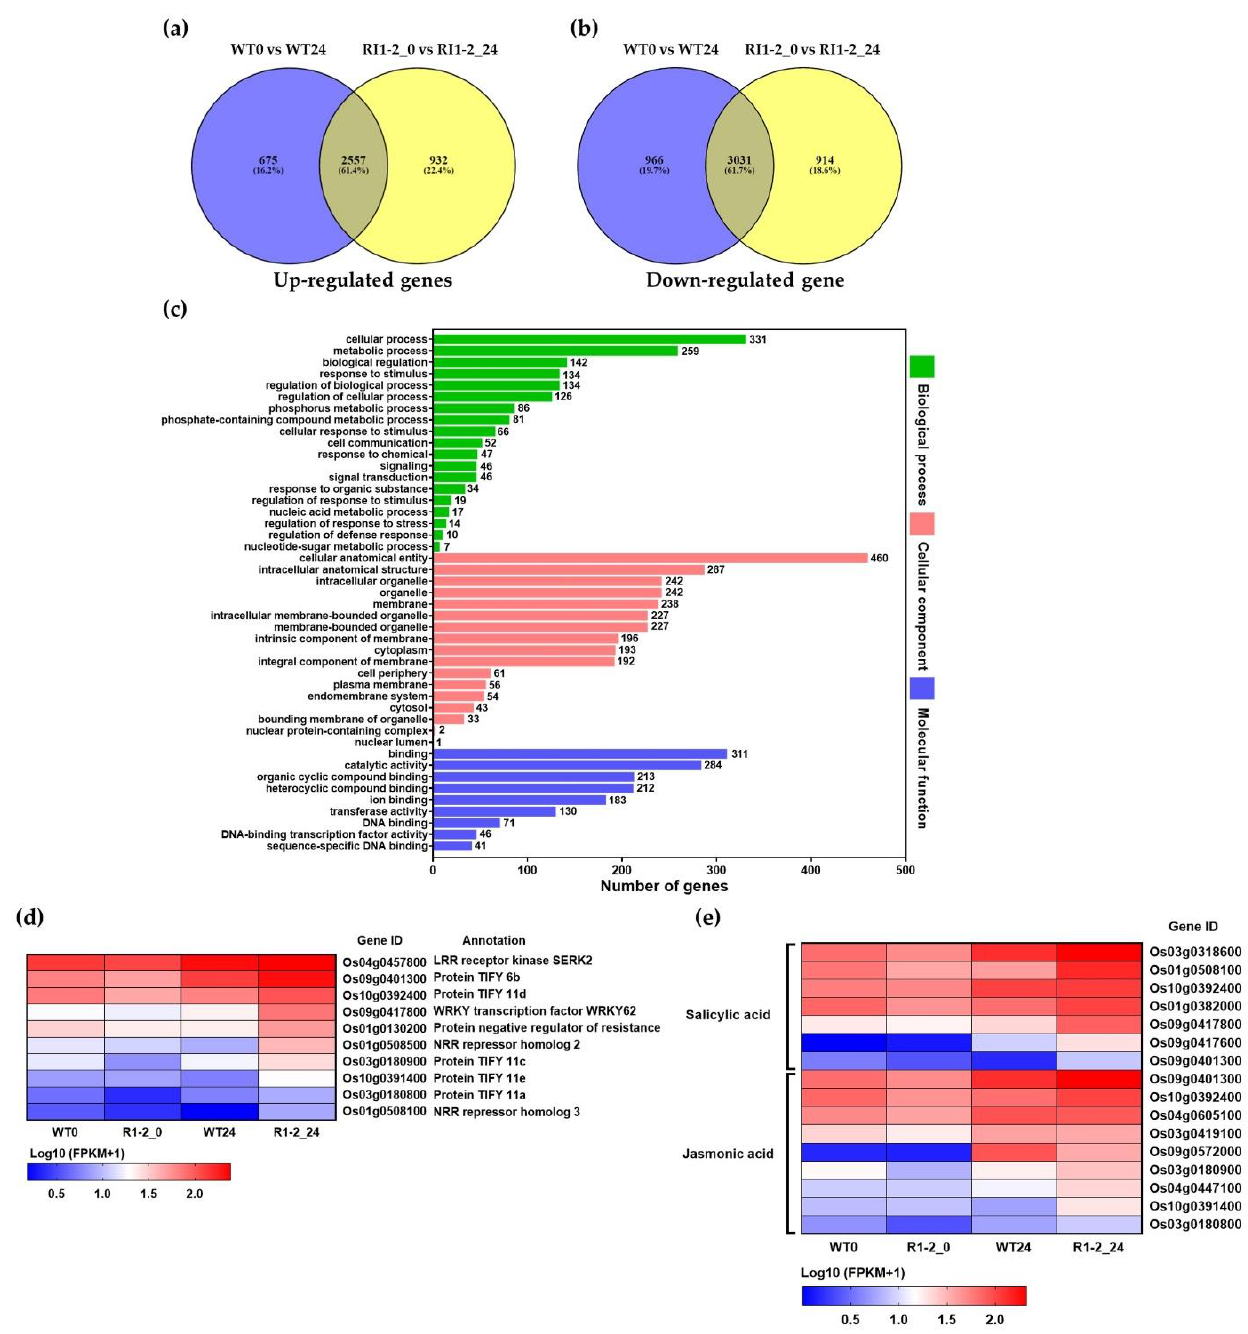
Figure 6. Transcriptome analysis in wild-type (WT) and OsVTC1-1 RI1-2 line at 0 and 24 hpi with rice blast 10100 isolate. ( a ) Venn diagram of up-regulated differentially expressed genes (DEGs) and ( b ) down-regulated DEGs; ( c ) gene ontology (GO) enrichment analysis of up-regulated DEGs in the OsVTC1-1 RI1-2 line in terms of biological process (green), cellular component (pink), and molecular function (blue); ( d ) heatmap of up-regulated DEGs related to defense response; ( e ) heatmap of up-regulated DEGs related to plant hormone synthesis and signaling pathways. The gene expression levels are presented by log10 (FPKM+1) values. Red color displays high expression levels of genes and blue color represents low expression levels of genes.